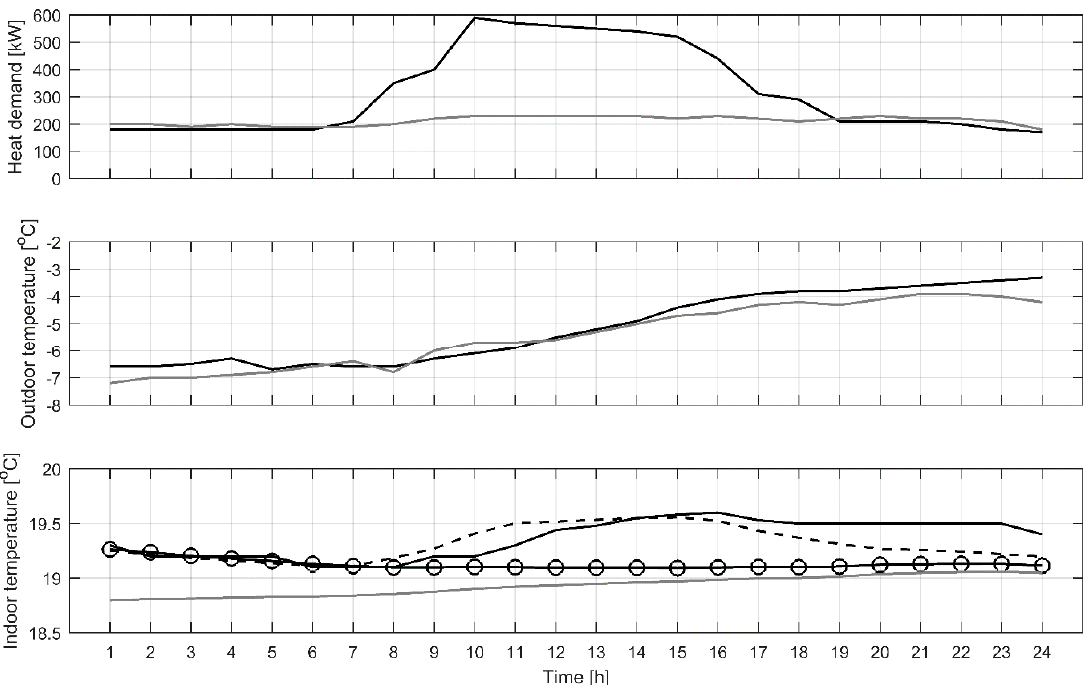
Figure 8. An example on the optimization of the heat demand in building A for a 24-h period. Upper: Measured heating powers for simulation day (black) and reference day (grey). Middle: Measured outdoor temperatures for simulation day (black) and reference day (grey). Lower: Measured (solid black) and simulated (dashed black) indoor temperature for simulation day and measured indoor temperature for reference day (grey). Black line with circles is the simulated indoor temperature for simulation day using reference day heating power.